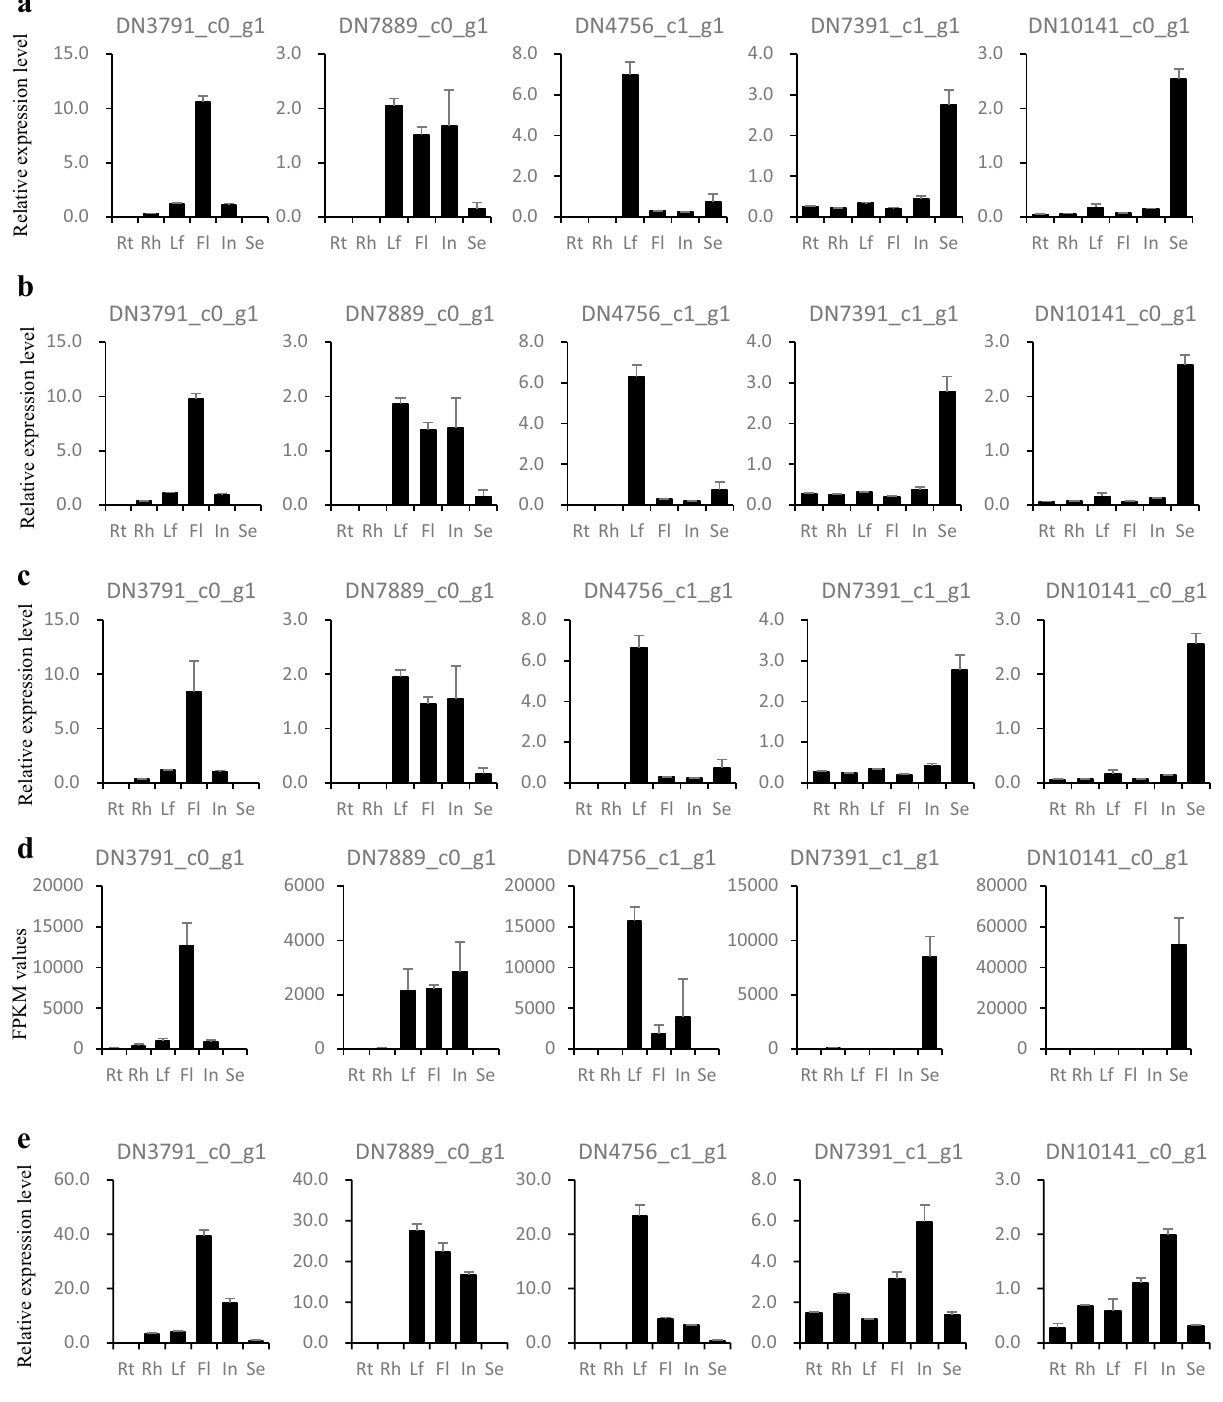
Figure 5. Expression analysis of five randomly selected genes across various A. tuberosum tissues. Expression patterns of selected genes were generated by qRT-PCR results normalized against the most stable genes, DN374_c0_g1 ( a ), DN253_c0_g1 ( b ), and in combination ( c ), or against the least stable gene DN900_c0_g1 ( e ). Expression level of selected genes in different tissues was presented according to the A. tuberosum transcriptome data ( d ). All these bars was represented by mean ± SD from three biological